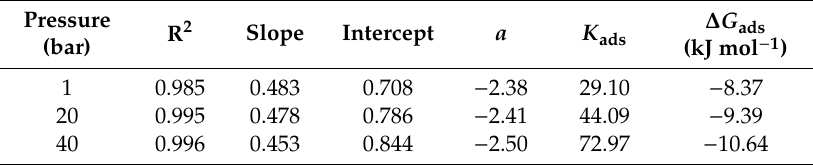
Table 3. Parameters of the Temkin’s adsorption isotherm calculated from weight loss measurements after 24 h of immersion time.